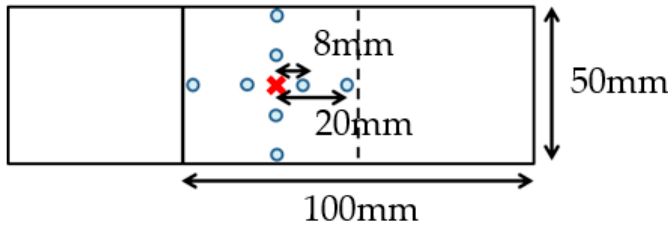
Figure 8. Single spot specimen and measuring points.